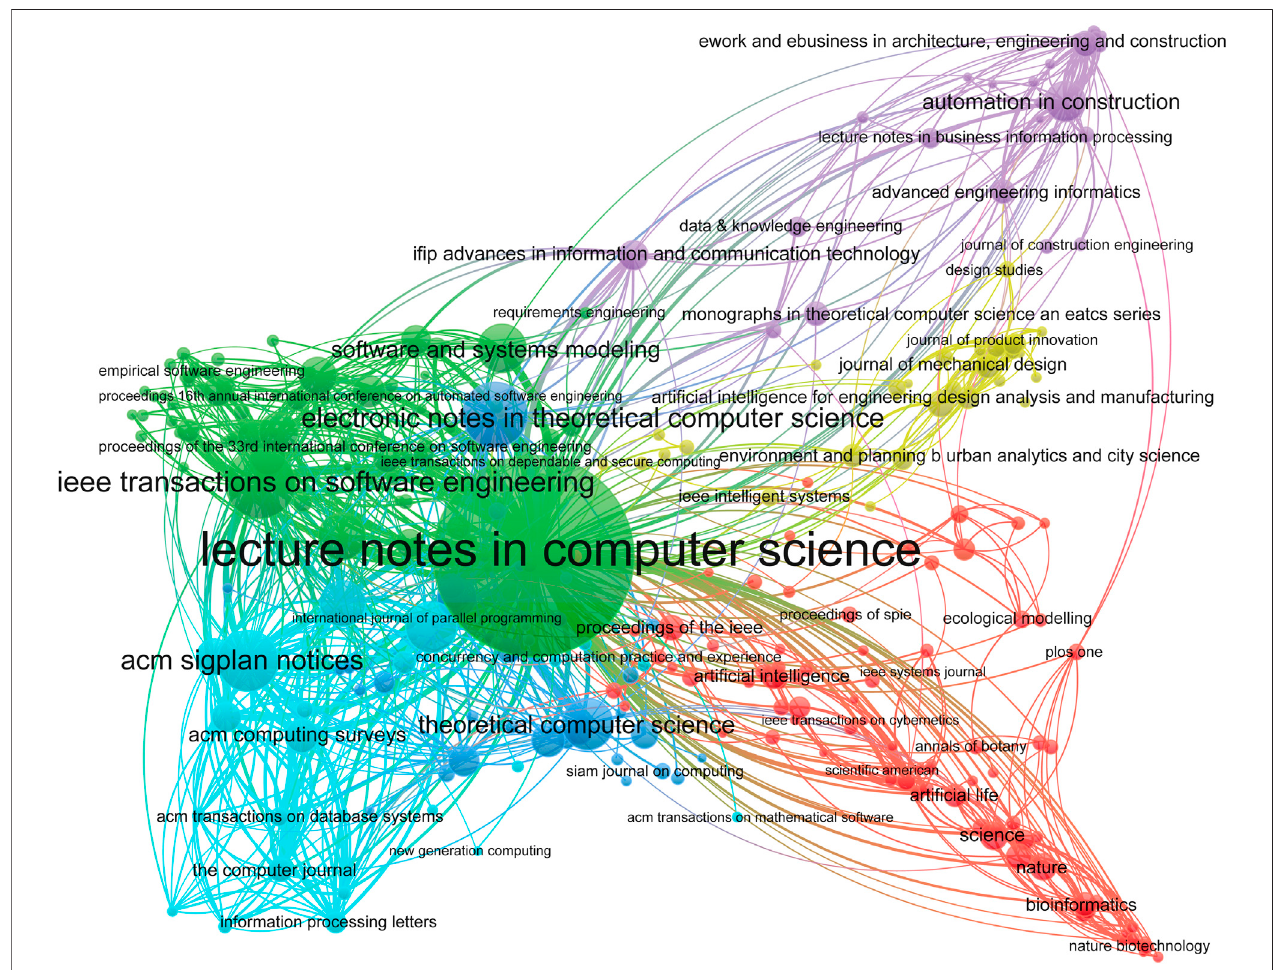
FIGURE2| Bibliographyanalysisofcitationsbetweenpublicationsources.Labelandcirclesizescorrespondtothetotalnumberofdocuments.Theseresultswere collected by searching Scopus 1 for the keywords Graph Rewriting , Engineering , and Design . The visualization was performed using VOSViewer 2